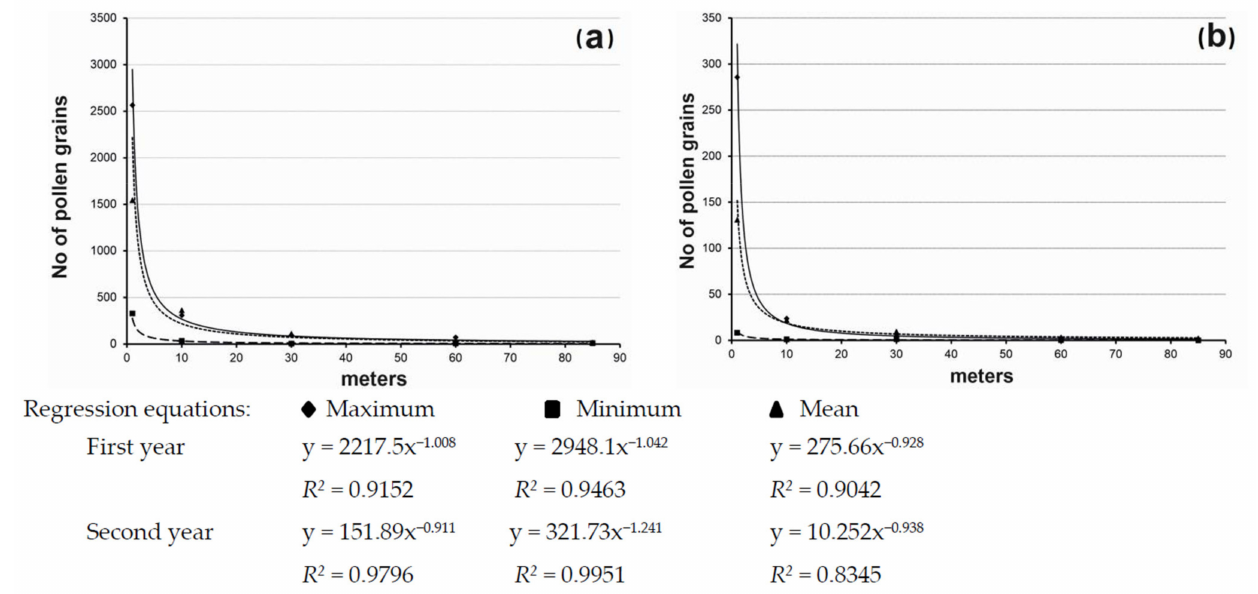
Figure 4. The number of pollen grains on slides as a function of distance from the field with transgenic winter triticale plants in the first ( a ) and the second ( b ) year of the experiment; for both graphs: maximal values—solid line, minimal values—dashed line, mean values—dotted line.